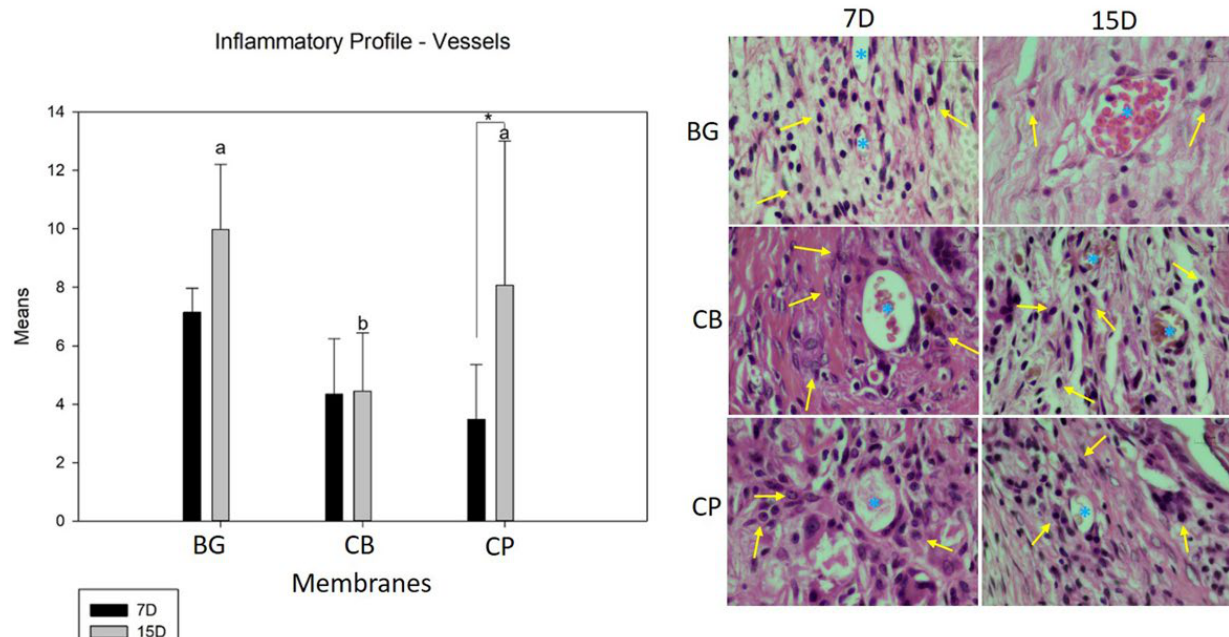
Figure 3. The graph shows the comparisons of means and standard deviations within and between groups for the analysis of the number of blood vessels in the period of 7 and 15 days. The lowercase letters show a statistically significant difference for the period of 15 days ( p = 0.005); there is no statistical difference for the 7-day period. The * demonstrates whether there is a statistically significant difference within the group in the period from 7 to 15 days ( p = 0.010). In the photomicrographs at 100 × magnification, the yellow arrows ( ↑ ) indicate the cells (lymphocytes) and the * indicates blood